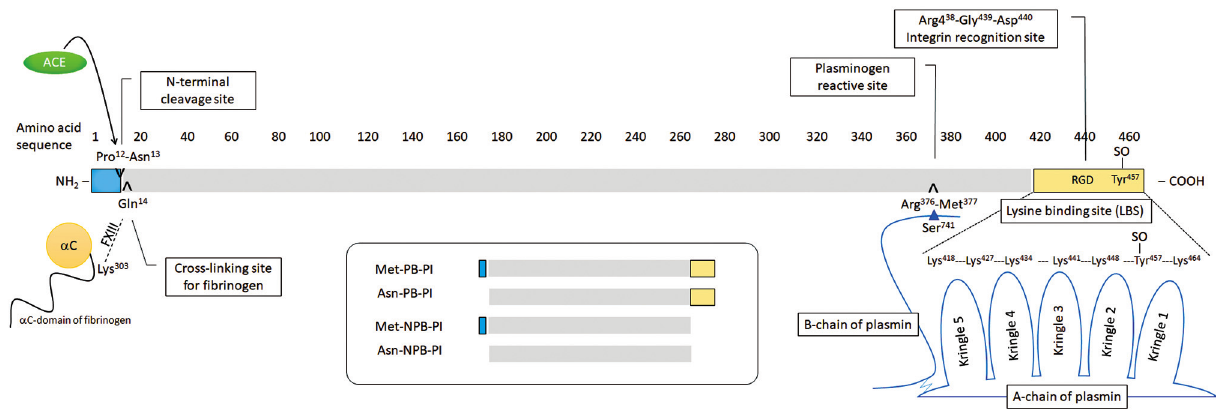
Fig. 1 Schematic representation of diversity forms of PI complexed with plasmin . PI includes a native form, which is 464 residues in length with N-terminal methionine (Met-PB-PI) and a truncated form, following digestion of the peptide bond between P12 and N13, leading to 12-residue shorter form (Asn-PB-PI). The N-terminal Q14-residue of PI is cross-linked to K303 in the A α -chains of fi brinogen, and this process is performed by antiplasmin-cleaving enzyme (ACE) and catalyzed by activated coagulation factor XIII in the presence of Ca 2 þ ions. The C-terminal portion of antiplasmin contains a 51-residue extension with a secondary binding site that recognizes the lysine-binding sites of plasminogen and plasmin. PI, plasmin